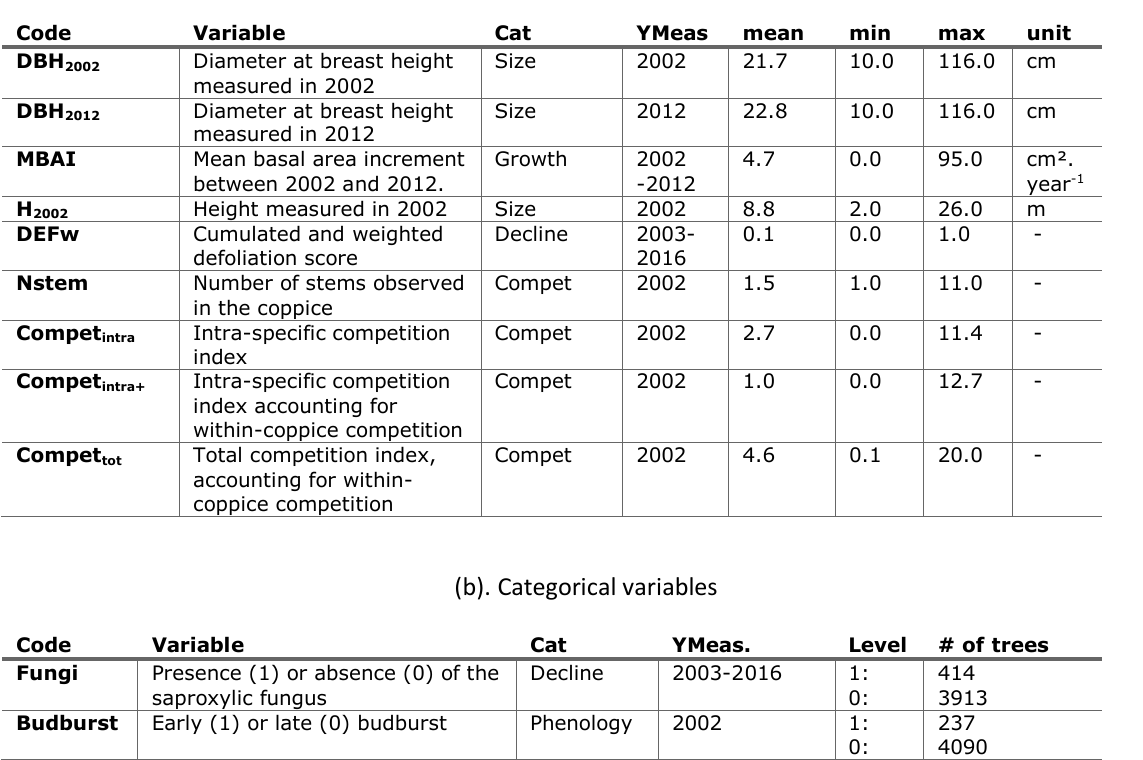
Table 1: Quantitative (a) and categorical variables (b) measured at individual level. All the variables were measured in 4323 trees, except for H 2002 (1199 trees). The “Cat” column indicates the category (i.e. size, growth, competition, decline, phenology). The “YMeas.” column indicates the year of measurement; note that all the variables were measured only once, so when two dates are given they indicate the period over which the variable is computed. (a). Quantitative